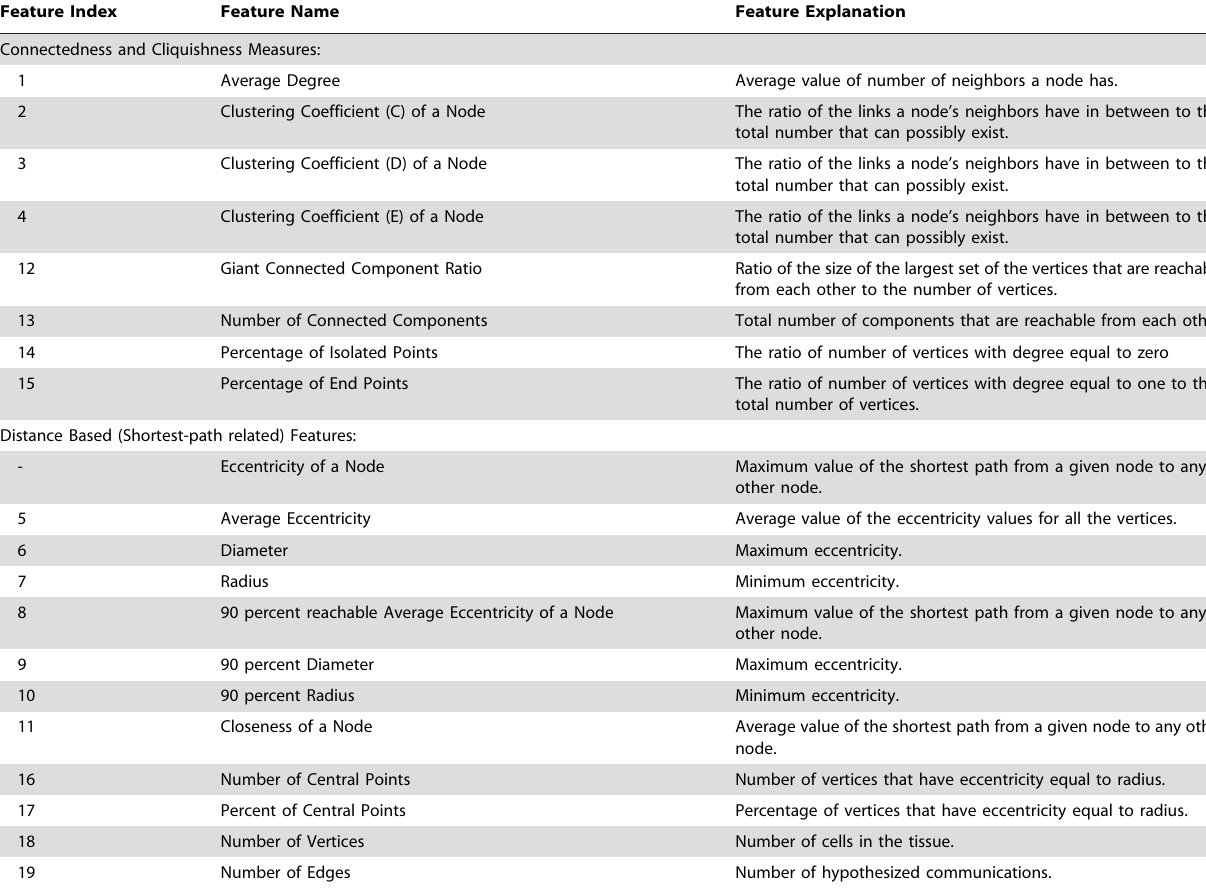
Table 1. Global structural